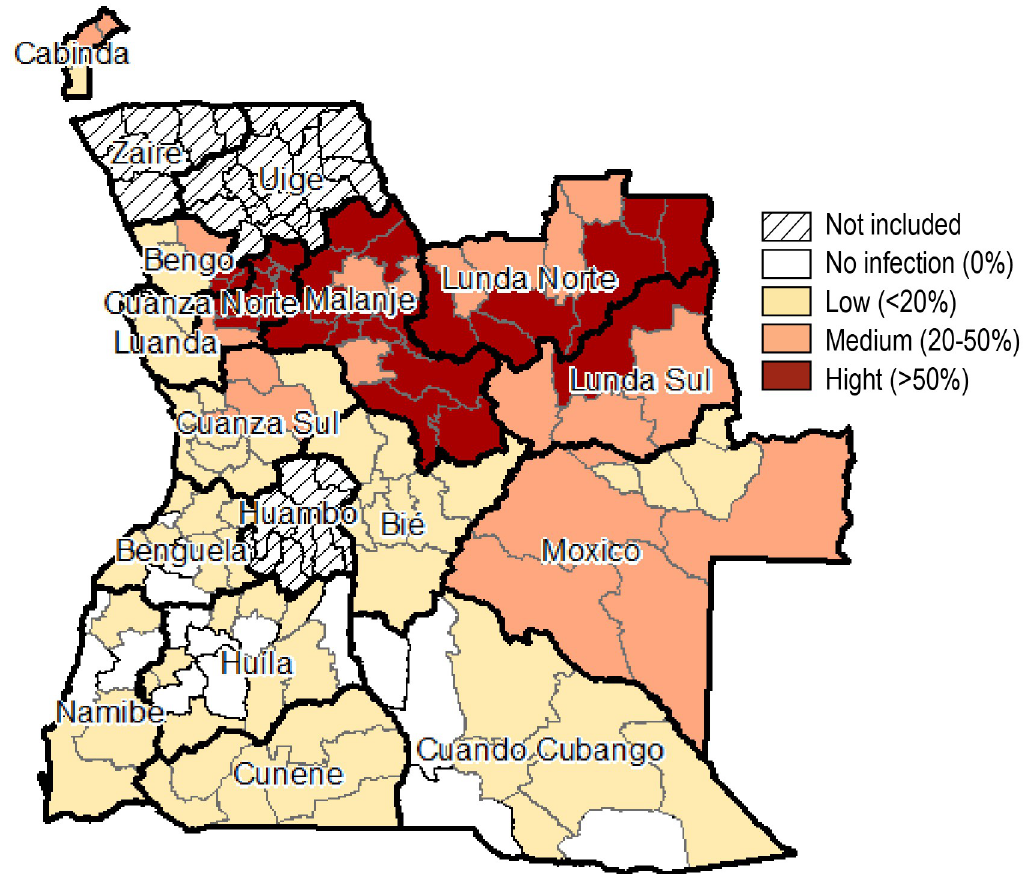
Fig 2. Soil Transmitted Helminthiasis risk (derived from STH prevalence) across 15 provinces of Angola (2018/2019). (Source: Ministry of Health Angola).